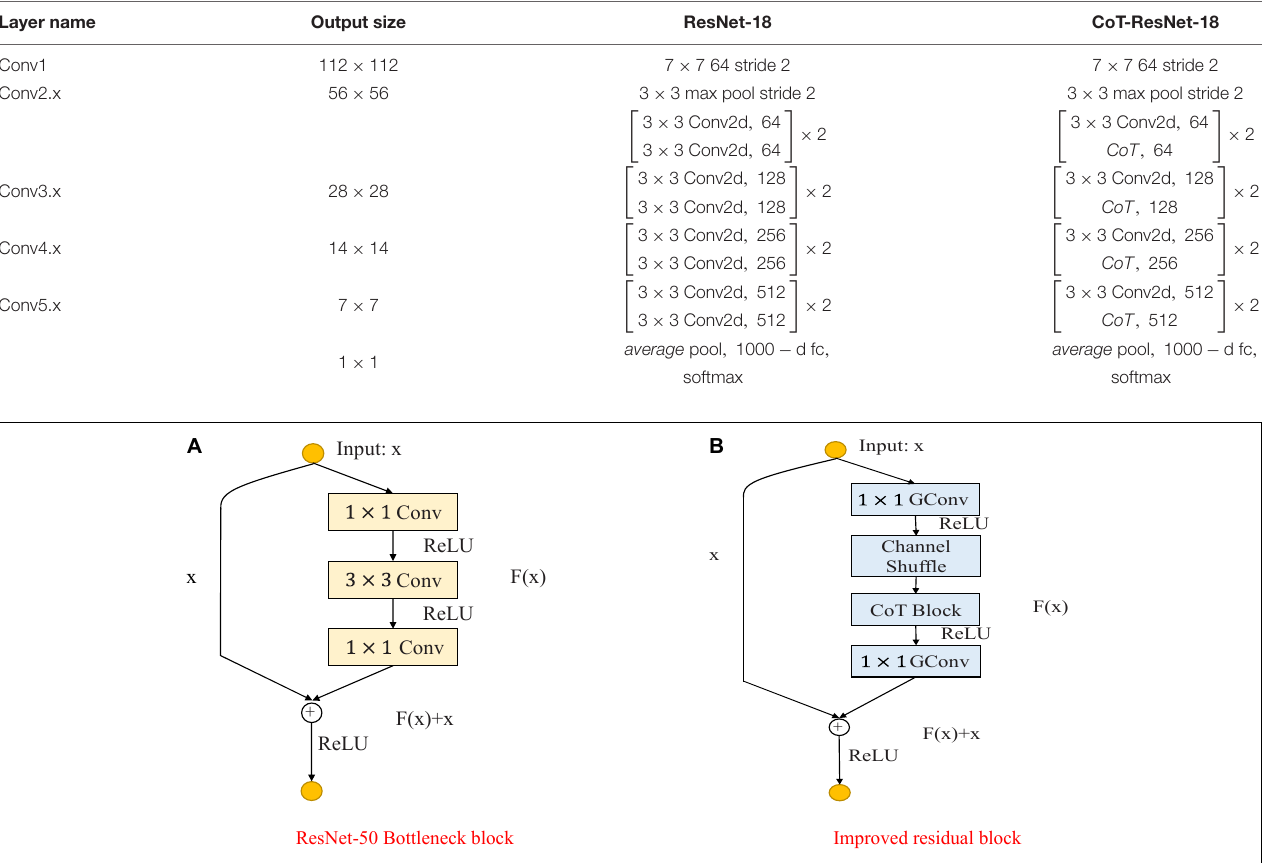
FIGURE 5 | Comparison of the improved ResNet-50 residual block. (A) ResNet-50 residual block. (B) Improved residual